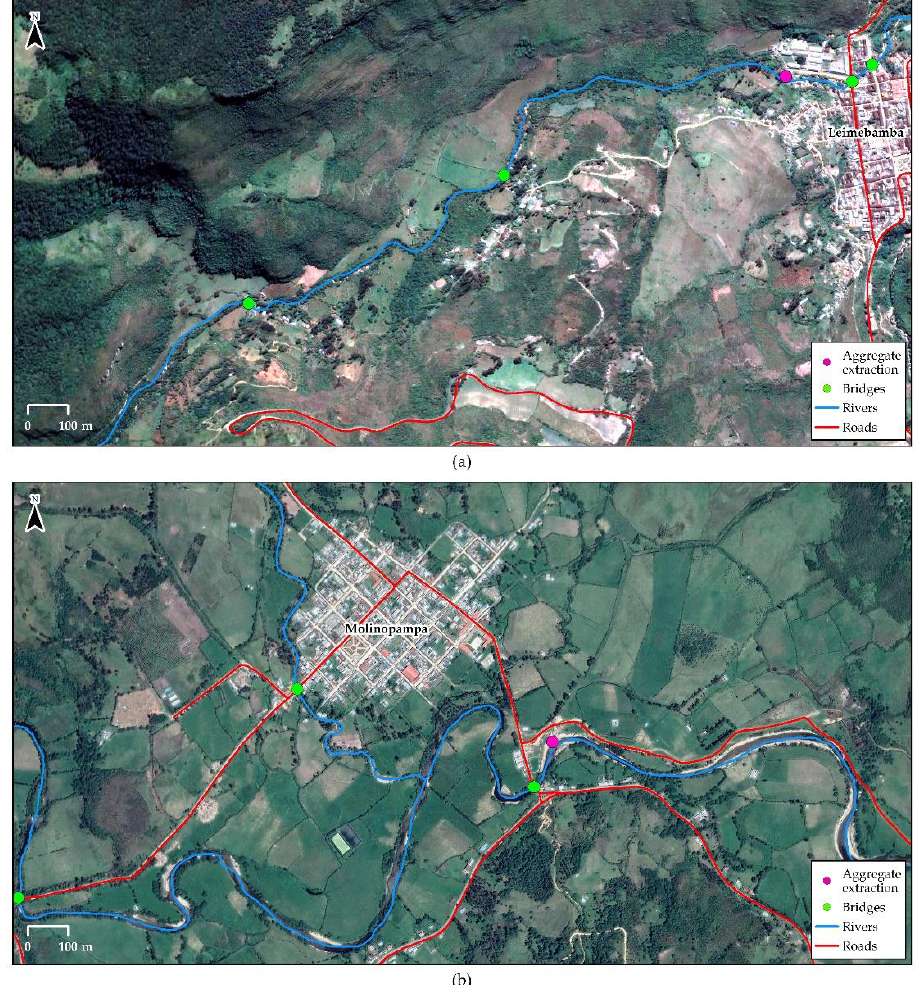
Figure 4. Identification of processes and impacts in the river system using satellite imagery in the ( a ) Pomacochas HAL-MW in Leimebamba and ( b ) Ventilla HAL-MW in Molinopampa (Amazonas, Peru). The images show the loss of the floodplain due to intense agricultural activity and the presence of anthropic infrastructures in the river